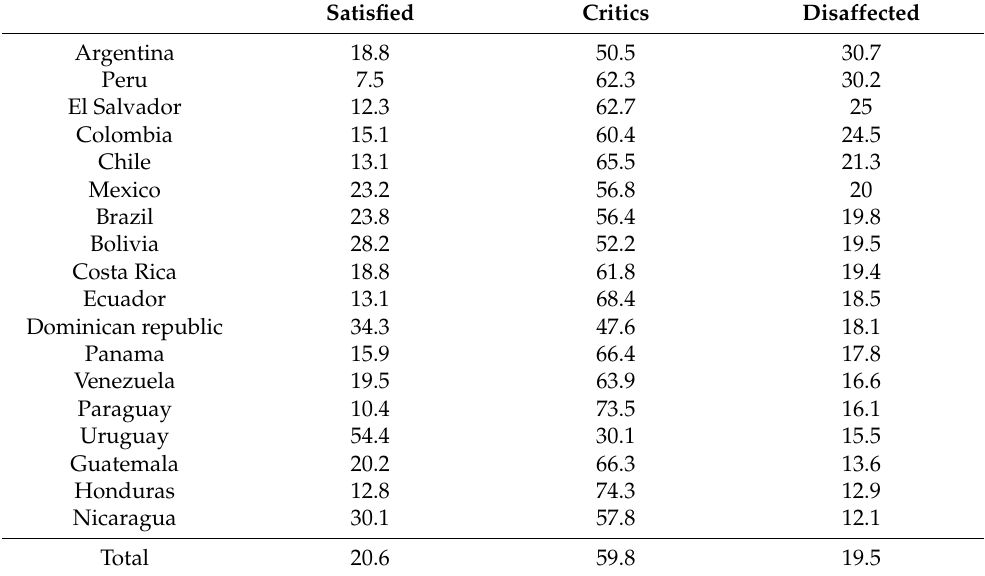
Table 2. Citizen